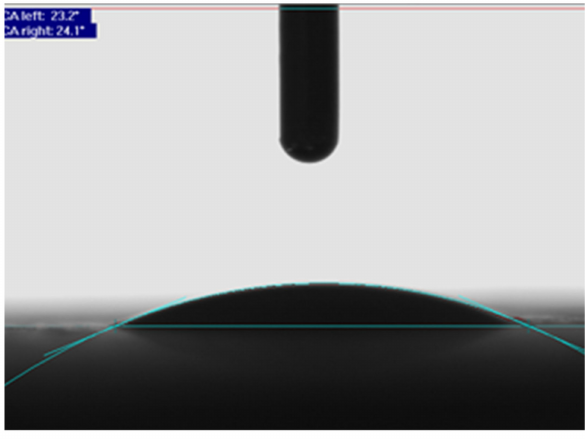
Figure 2. Illustration of measurement of the contact angle.